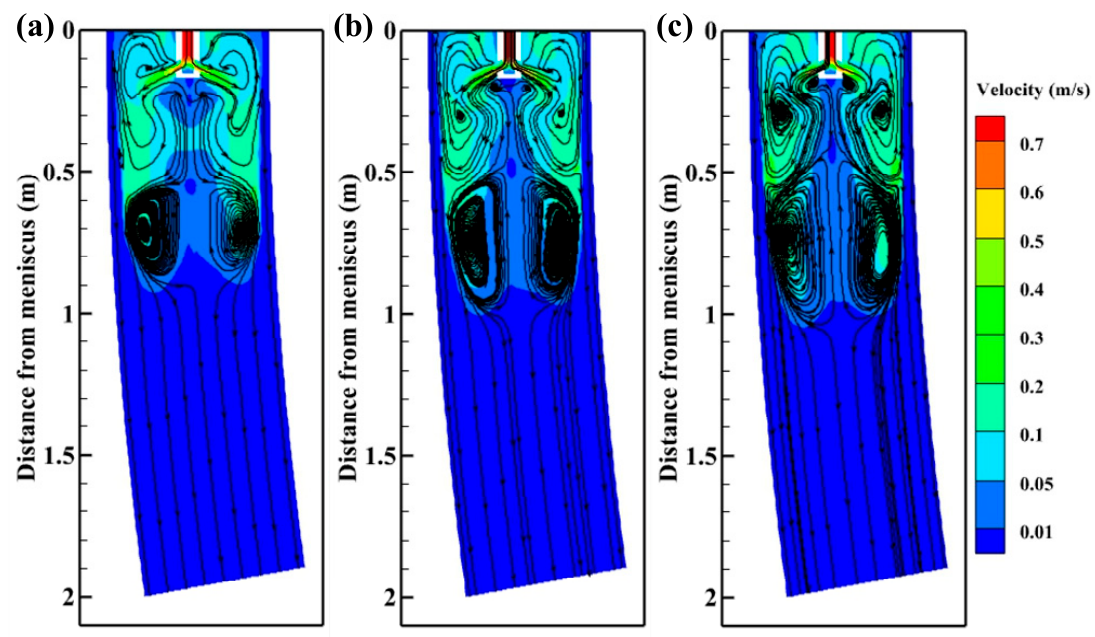
Figure 11. Velocity contours and streamlines on the plane Y = 0 m with M-EMS ( a ) –15° SFN, ( b ) 0° SEN, and ( c ) +15° SFN.